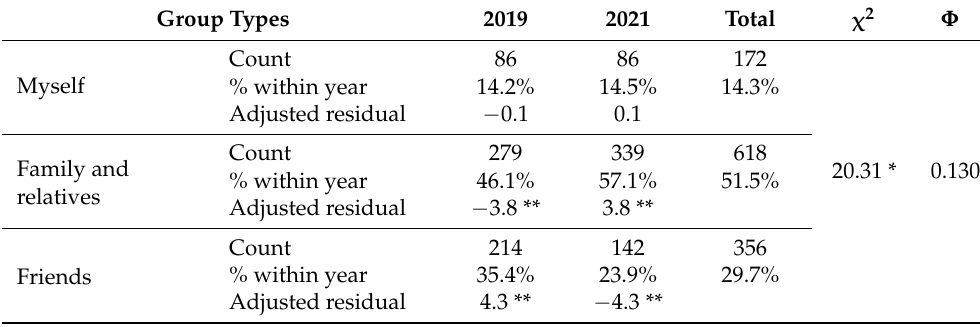
Table 1. Chi-square analysis of group types (2019 vs.